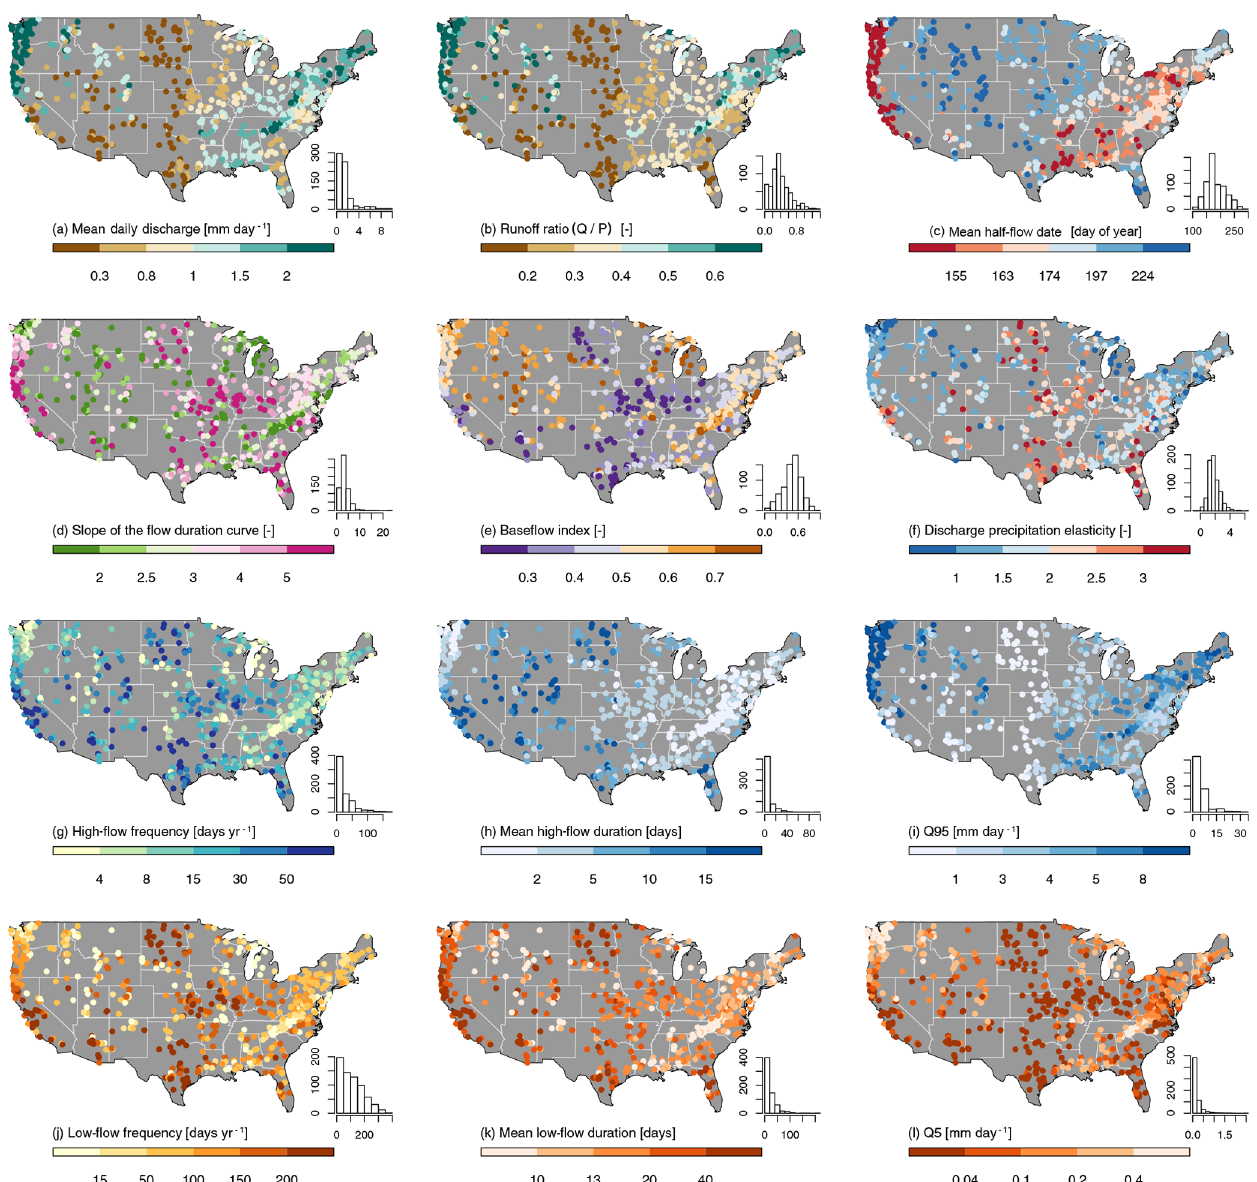
Figure 4. Maps of hydrological signatures over the CONUS. The histograms indicate the number of catchments (out of 671) in each bin.